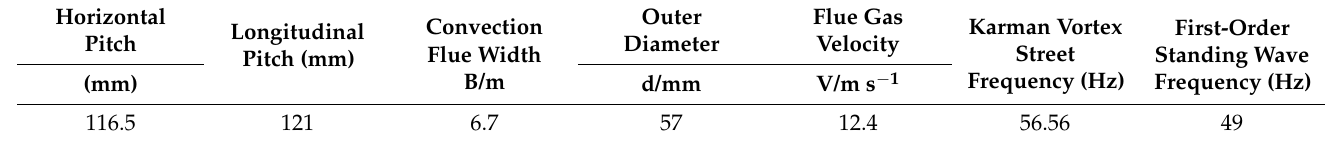
Table 1. Shedding frequency and first-order standing wave frequency at rated operating conditions.